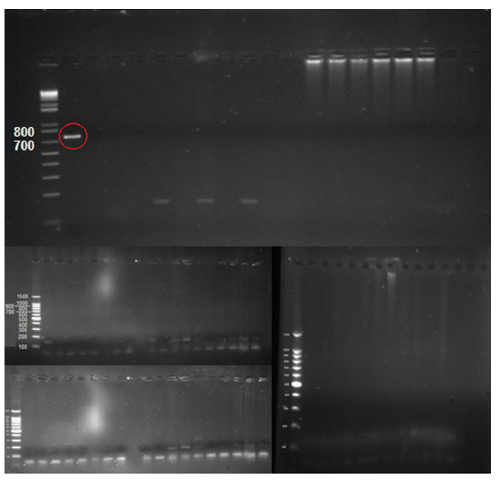
Figure 5. 1% Agarose Gel Electrophoresis. All the samples tested negative for X. fastidiosa . The band in the second well, circled in red, is the positive control (DNA from an inactivated in vitro culture of X. fastidiosa CoDiRO